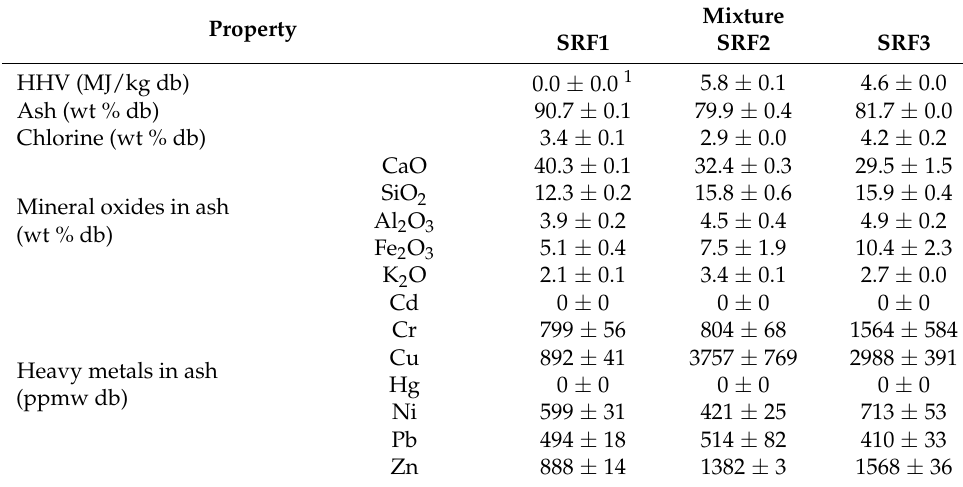
Table 7. Composition and properties of gasification